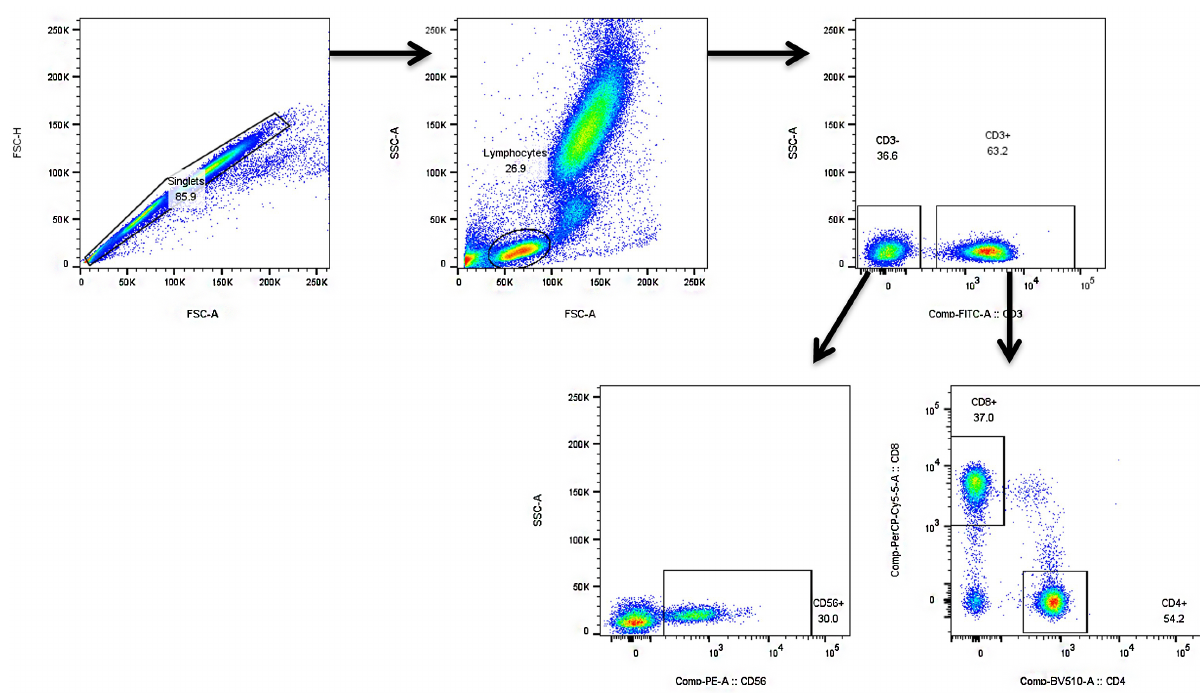
Fig. 1. Flow cytometry gating strategy. Singlet cells were gated by area and height of forward